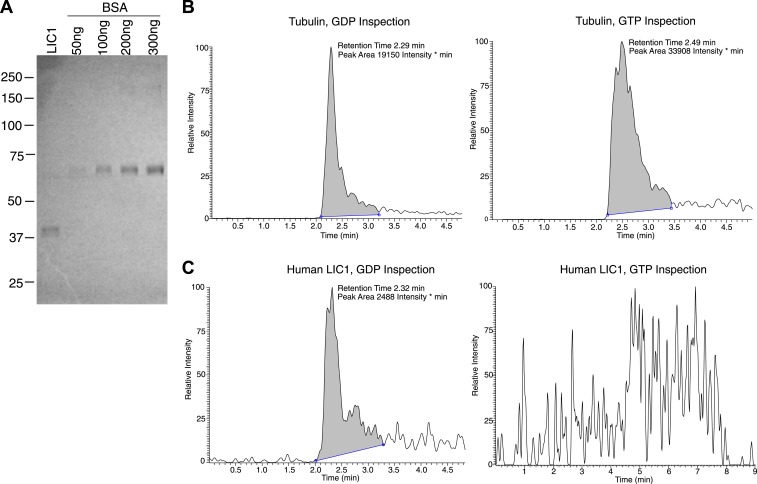
Human LIC1 co-purifies with GDP from human cells.(A) Strep-tagged human LIC1 (a.a. 1–354) was purified from HEK-293T cells using Strep-Tactin beads. A sample (1 μL) of the final concentrated LIC1 (50 μL total) is displayed beside varying amounts of BSA. The 1/50th sample of purified human LIC1 is approximately 150 ng, which allows for an estimation of approximately 7.5 μg total. (B) Purified porcine brain tubulin (175 μg) was buffer exchanged into 50 mM NH4OAc, concentrated to approximately 3.5 μg/μl. A 10 μl sample of a 4-fold dilution was analyzed by LC-MS for GDP and GTP based on mass, fragmentation and retention time. In the final scan, GDP and GTP (with approximate retention times of 2.3 min and 2.5 min, respectively) were both detected. (C) The 7.5 μg of human LIC1 shown in (A) was buffer exchanged into 50 mM NH4OAc and concentrated to approximately 188 ng/μl. LC-MS analysis was conducted as done with tubulin in (B). A distinct peak was seen for GDP, yet only background noise was present in the scan for GTP.